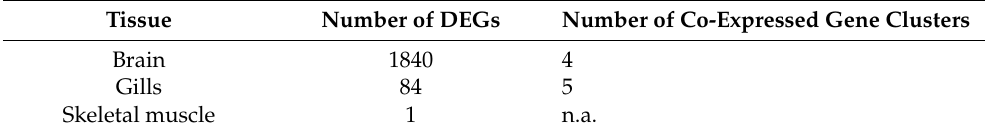
Table 3. Number of DEGs and relative co-expression clusters observed due to stabling in each